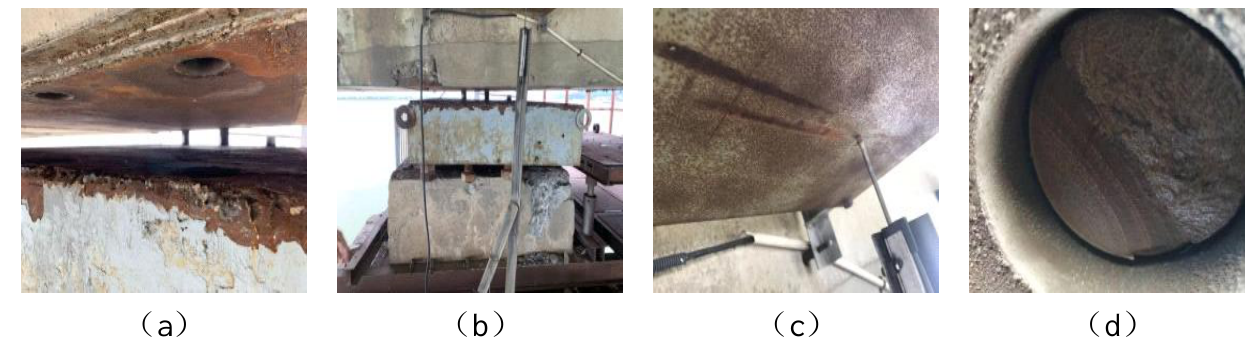
Figure 14. Schematic diagram of support failure: ( a ) the bolt is off, ( b ) the cushion stone is damaged, ( c ) the lateral displacement ( d ) the broken